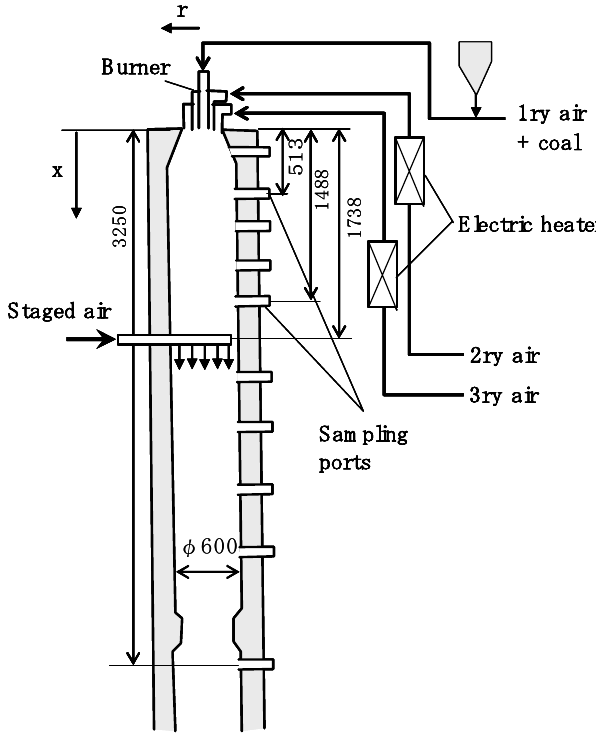
Figure 7. Schematic diagram of the laboratory scale furnace (unit: mm).